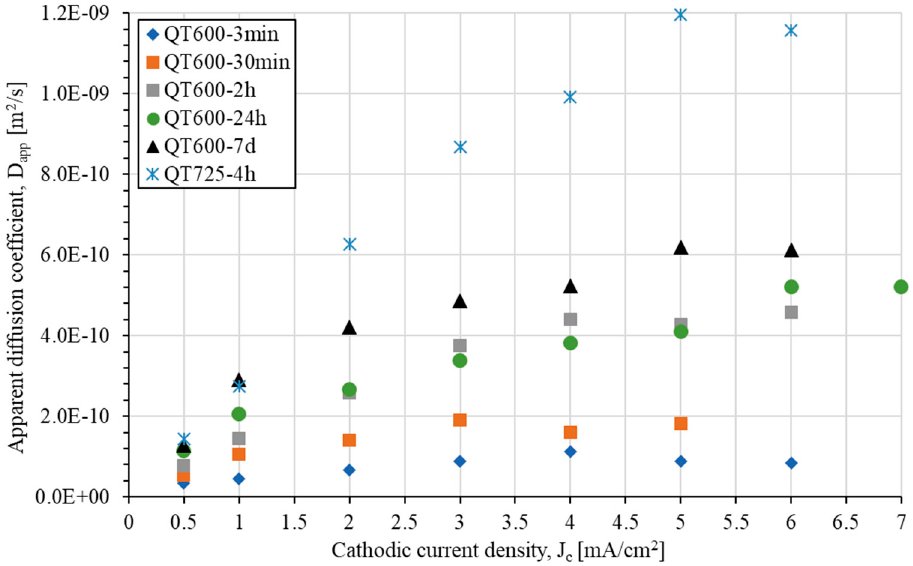
Figure 7. Evolution of D app with J c for the quenched and tempered 42CrMo4 grades. Table 6. D app (first transient) and D L of quenched and tempered 42CrMo4